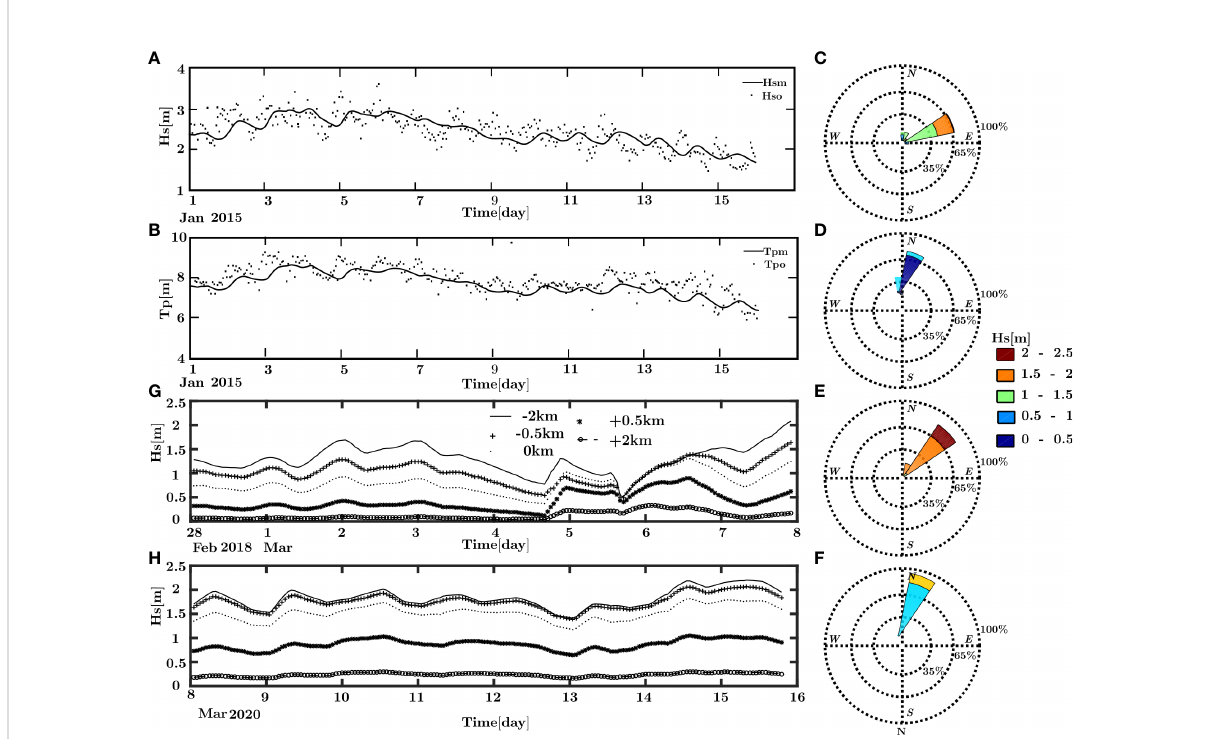
FIGURE 5 Comparison of measured [ (A) Hs and (B) Tp], and SWAN modeled wave parameters in the MRE plume (P1), (skill of 0.83 and 0.80 for Hs and Tp, respectively, were found). Waves rose from SWAN model results at -2 km (outer zone) in 2018 (C) and 2020 (E) , and 0.5 km (inner zone), in, (D) 2018 and (F) 2020. Signi fi cant wave heights are expected in (G) 2018 and (H) 2020 at various